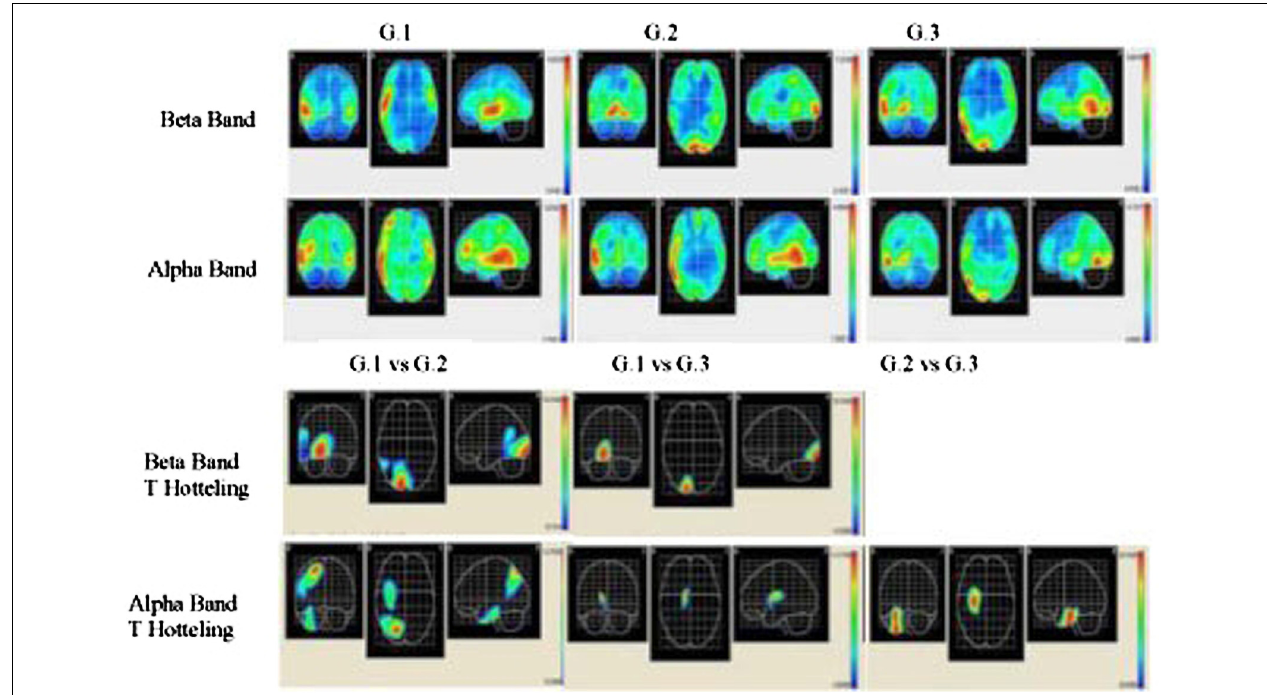
FIGURE 2 | Descriptive and comparative data of beta and alpha bands. Two upper rows show cortical intensity projection (LORETA) mean maps obtained each group. Maximal intensity projection areas